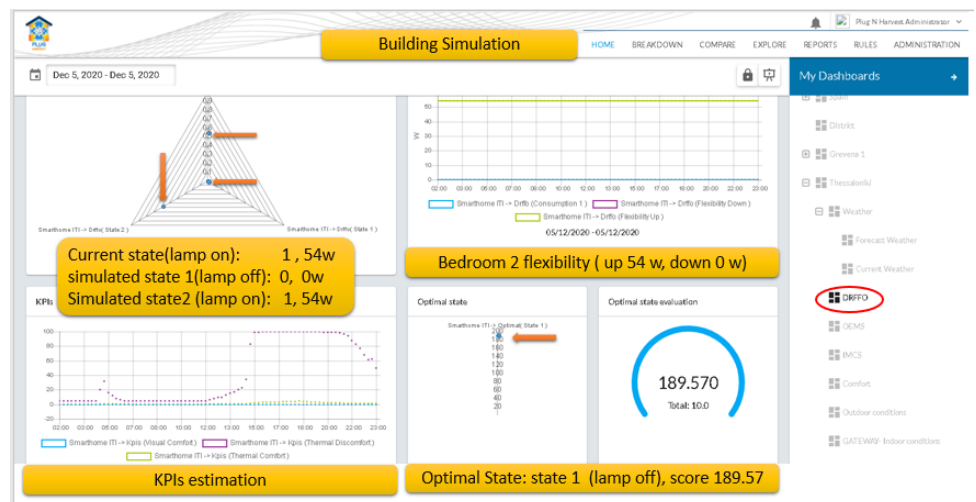
Figure 16. Current status DRFFO data and information.